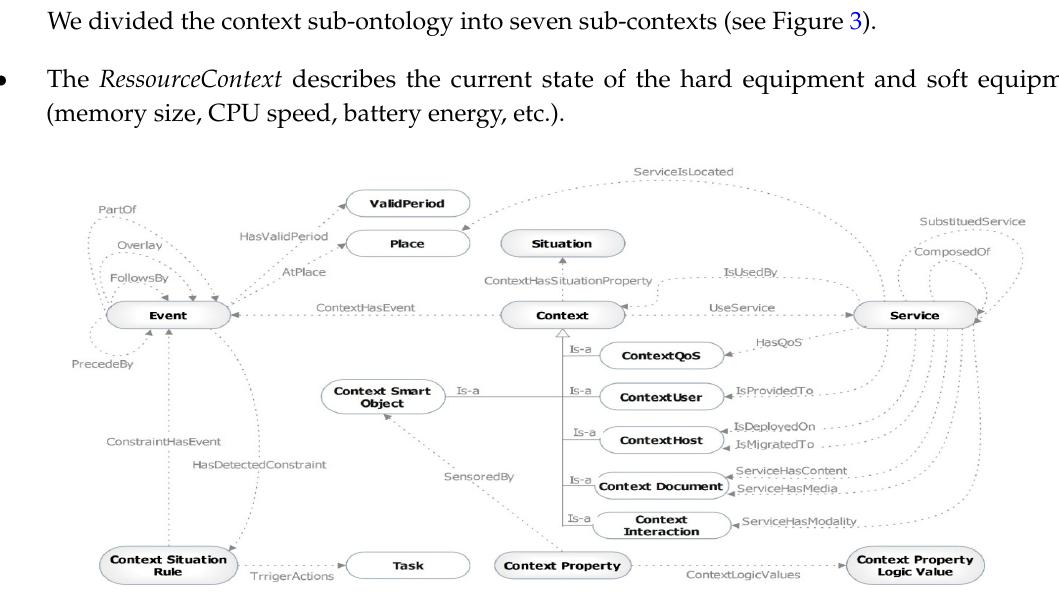
Figure 3. An overview of the structure of the common context ontology.